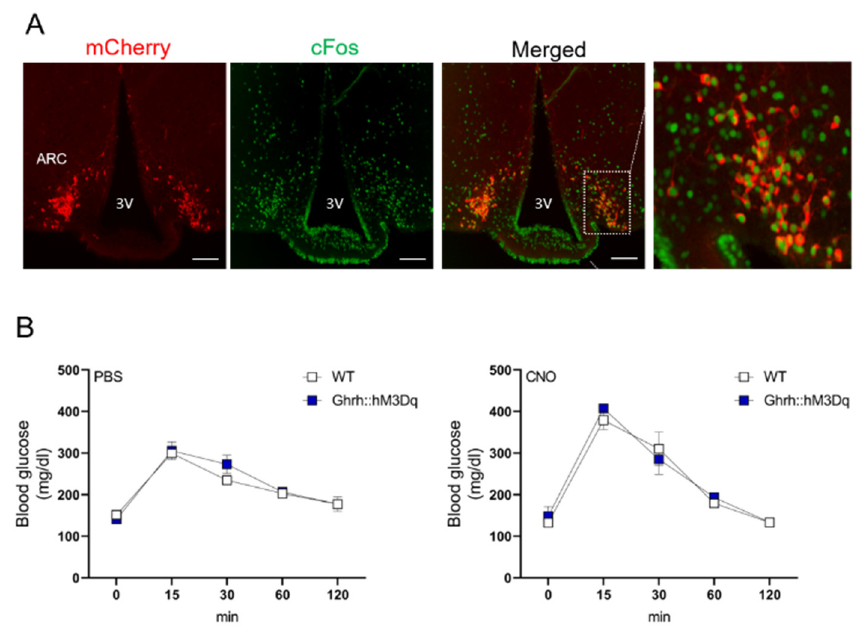
Figure 5. GHRH + neuron activation does not alter metabolic parameters. ( A ) Representative immunofluorescence for Ghrh::hM3Dq mice injected with CNO. mCherry (red) and c-Fos (green), dashed box indicates the region of the ARC demonstrating colocalization. 3V—third ventricle. Scale bar: 100 µm. ( B ) Glucose tolerance tests (GTT) of 12-week old male control and Ghrh::hM3Dq mice performed one week apart. PBS or CNO was injected 1 h before i.p. glucose injection (n = 3).